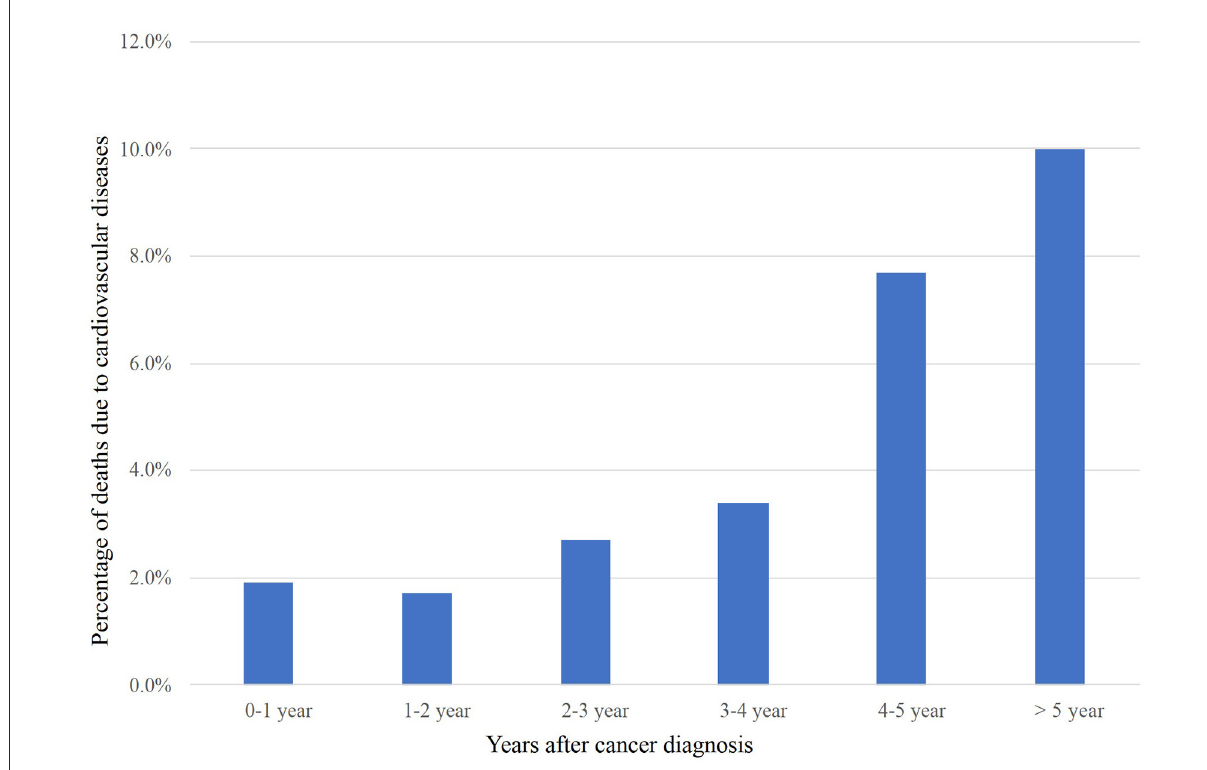
FIGURE2 CVM post-radiotherapy as a proportion of all deaths within a given time period after LS-SCLC diagnosis. CVM, cardiovascular mortality; LS-SCLC, limited-stage small cell lung cancer.